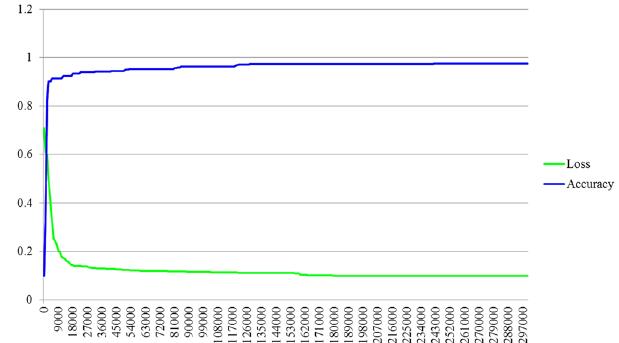
Figure 10. Training performance graph.